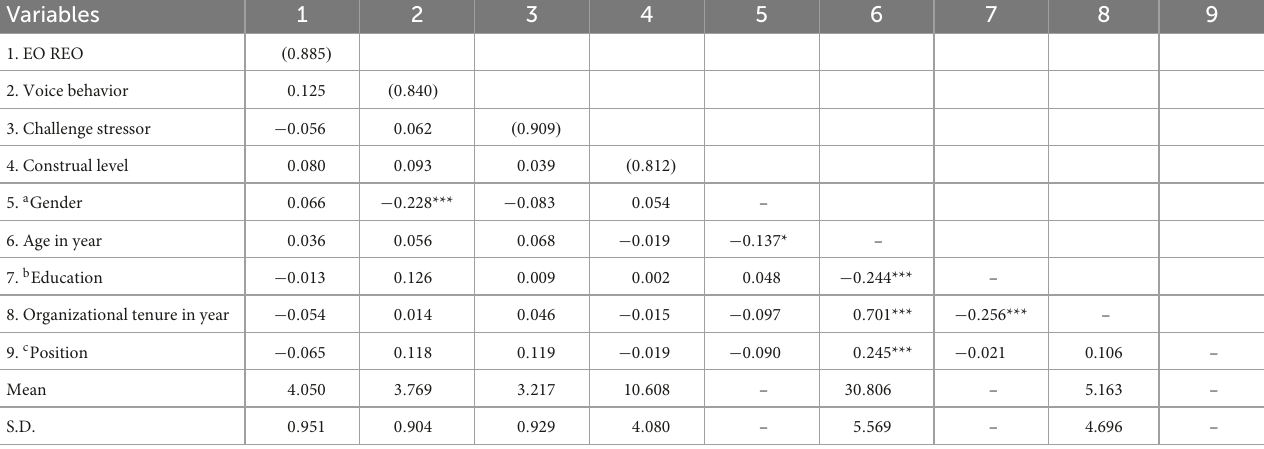
TABLE 1 The correlations between the variables in study 1.